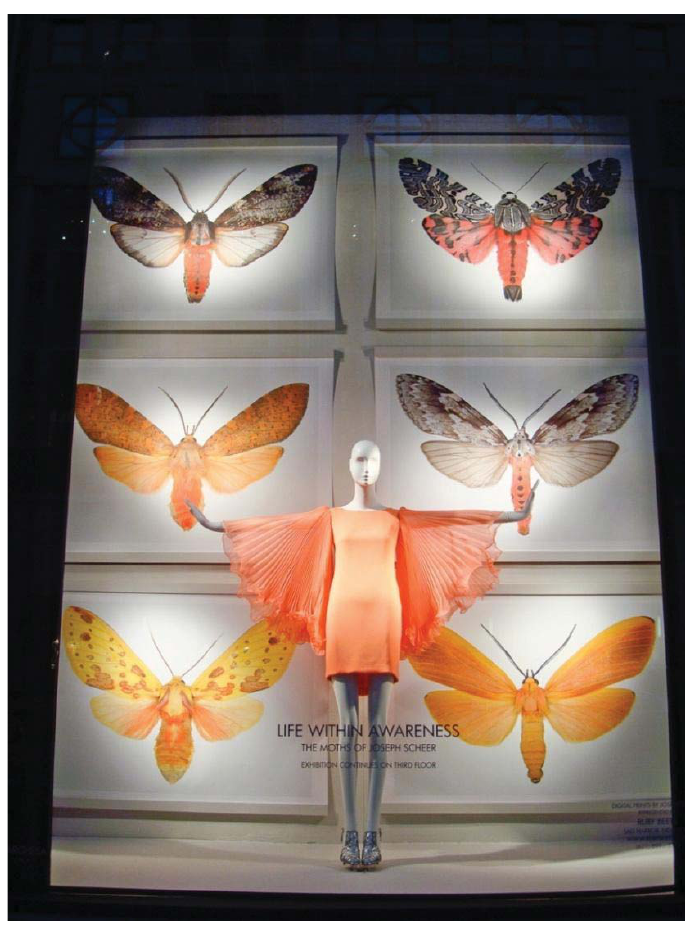
Figure 14. One of the Bergdorf-Goodman storefront windows on Fifth